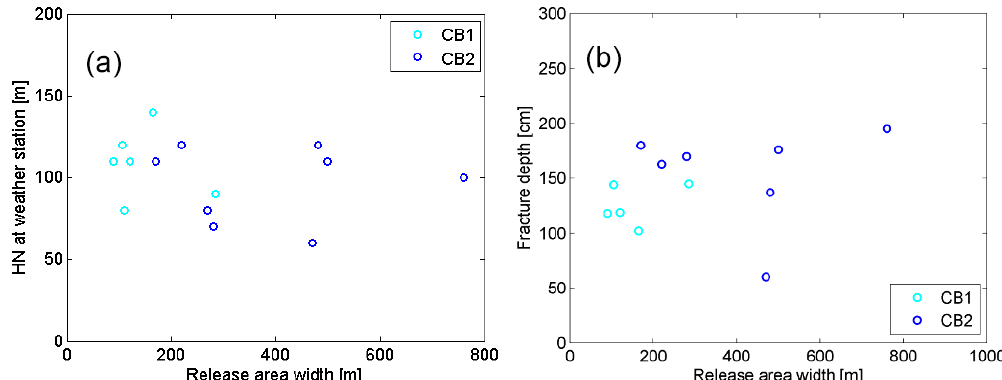
Figure 12. Release area width in the basins CB1 and CB2 as a function of (a) new snow depth of the snowfall period previous to avalanche release and (b) mean fracture depth.